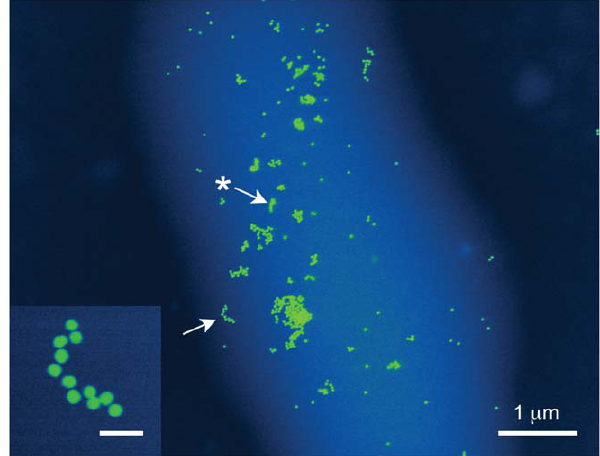
Figure 5. Wet STEM imaging of labeled E.coli bacterium with surface gold labels having a diameter of 30 nm. The inset is a selected area of a second image recorded at a 2.3 times larger magnification, showing the particles indicated by the arrow. Scale bar inset 100 nm. The arrow with the star points to gold labels that are out- of-focus. The signal intensity was color-coded, such that gold labels appear in yellow, the cell in light blue and the background in dark blue.